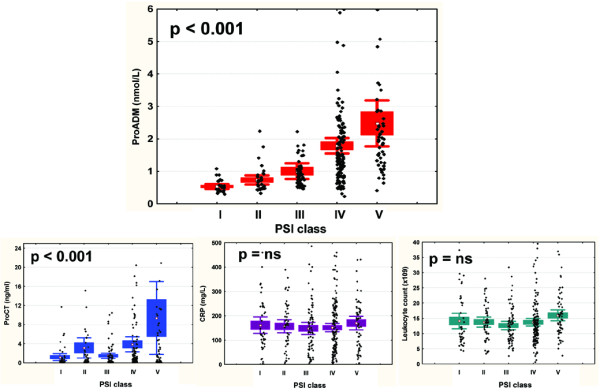
Pro-adrenomedullin (proADM), procalcitonin (proCT), C-reactive protein (CRP) levels and leukocyte count in different severities of community-acquired pneumonia. Data are shown as means ± standard error of the mean, with scatterplots representing all values. PSI, pneumonia severity index.